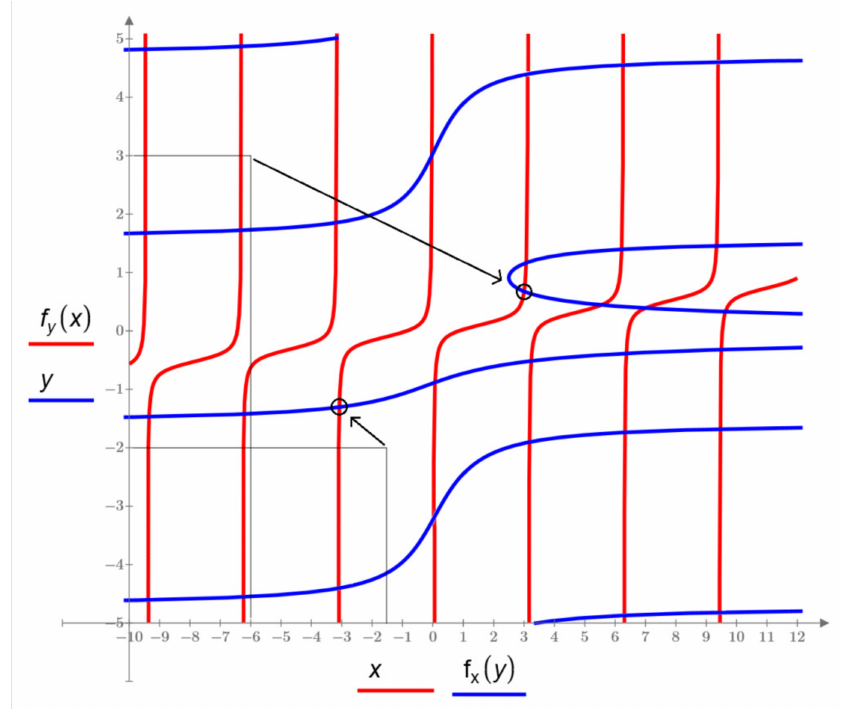
Figure 7. Graphical solution of system (1) in